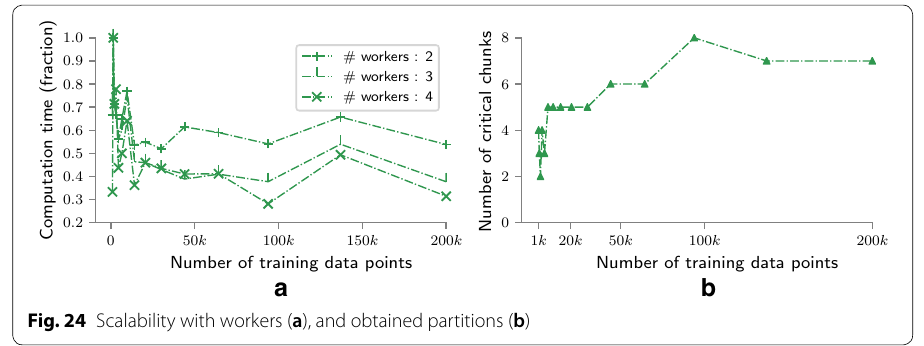
Fig. 24 Scalability with workers ( a ), and obtained partitions ( b )